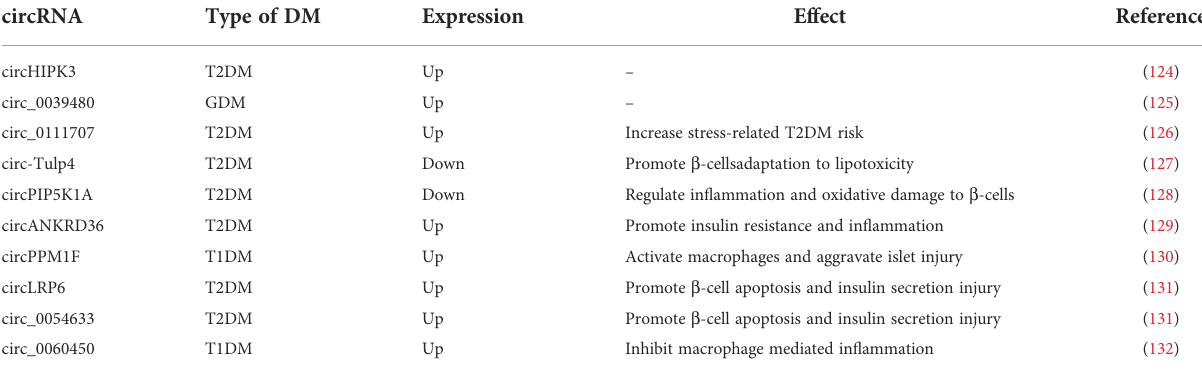
TABLE 3 The role of circRNAs in diabetes mellitus.